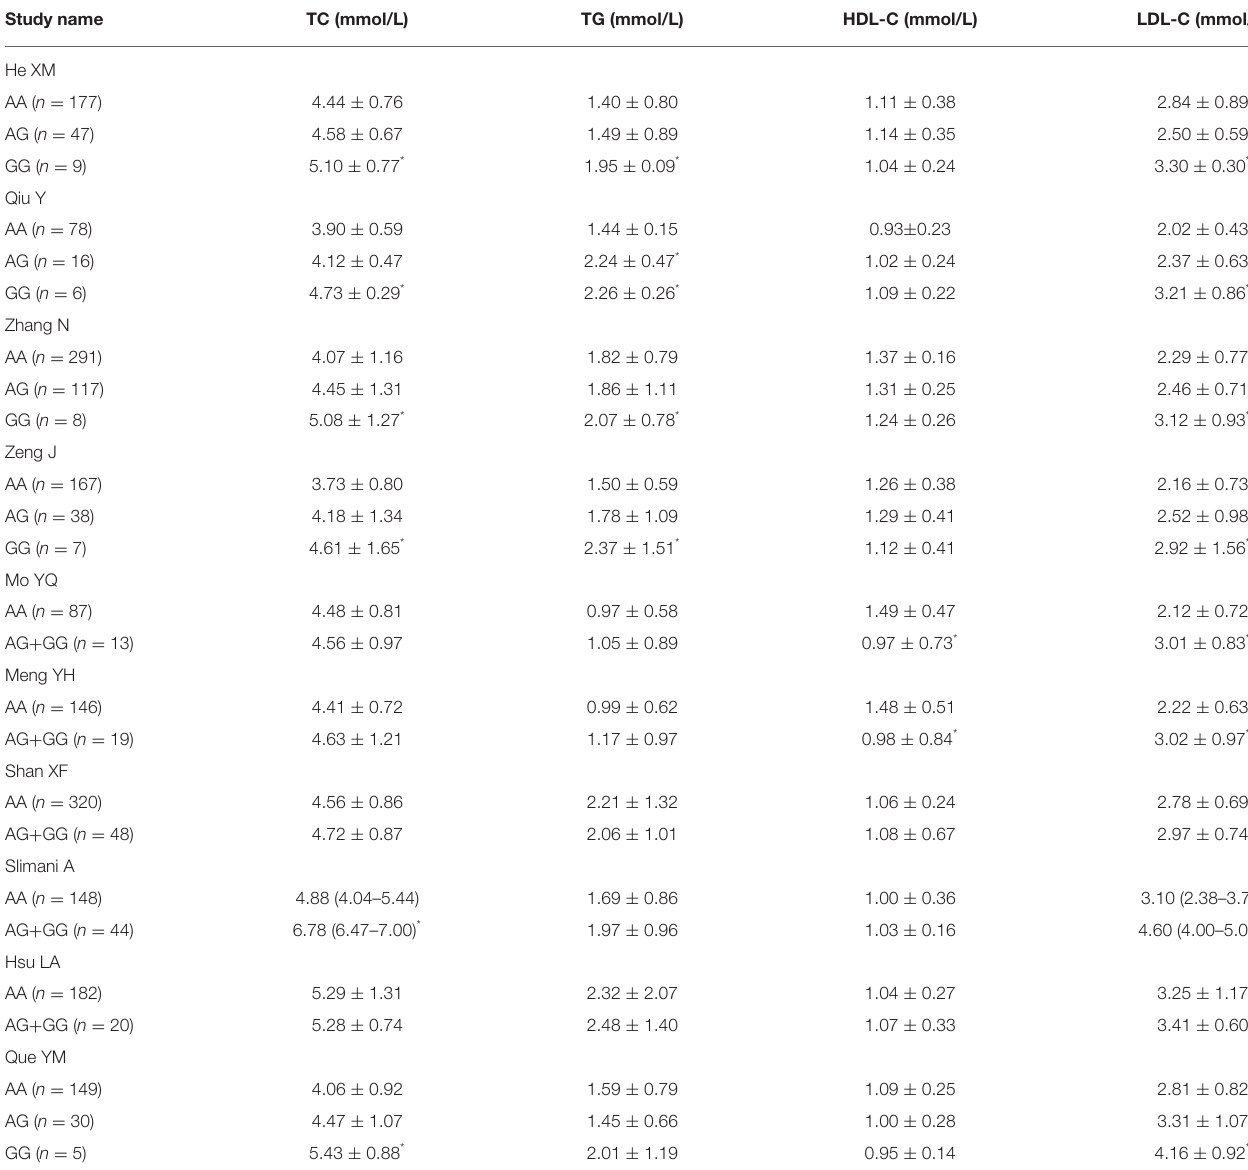
TABLE 3 | The association of lipid parameters values change and PCSK9 gene E670G mutation in the CAD patients in the included individual